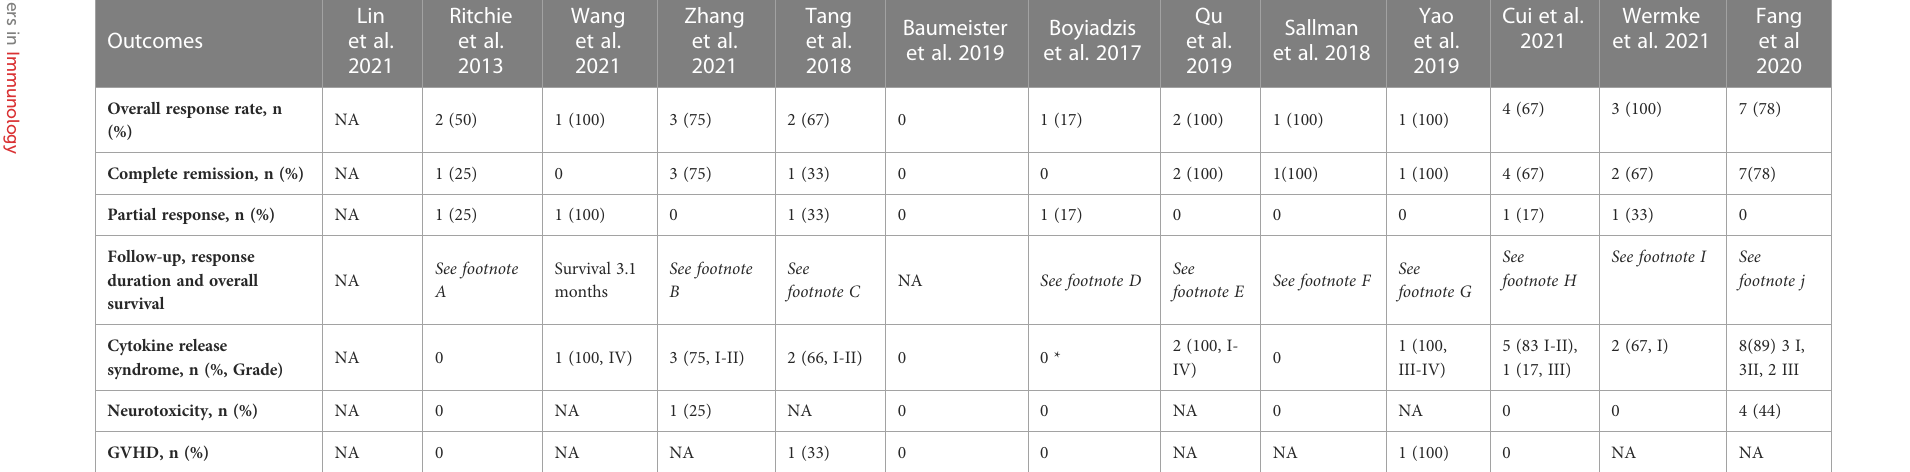
TABLE 2 Outcomes with Chimeric Antigen Receptor T-Cell (CAR-T) Therapy in Acute Myeloid Leukemia (n=57). Lin Outcomes et al.